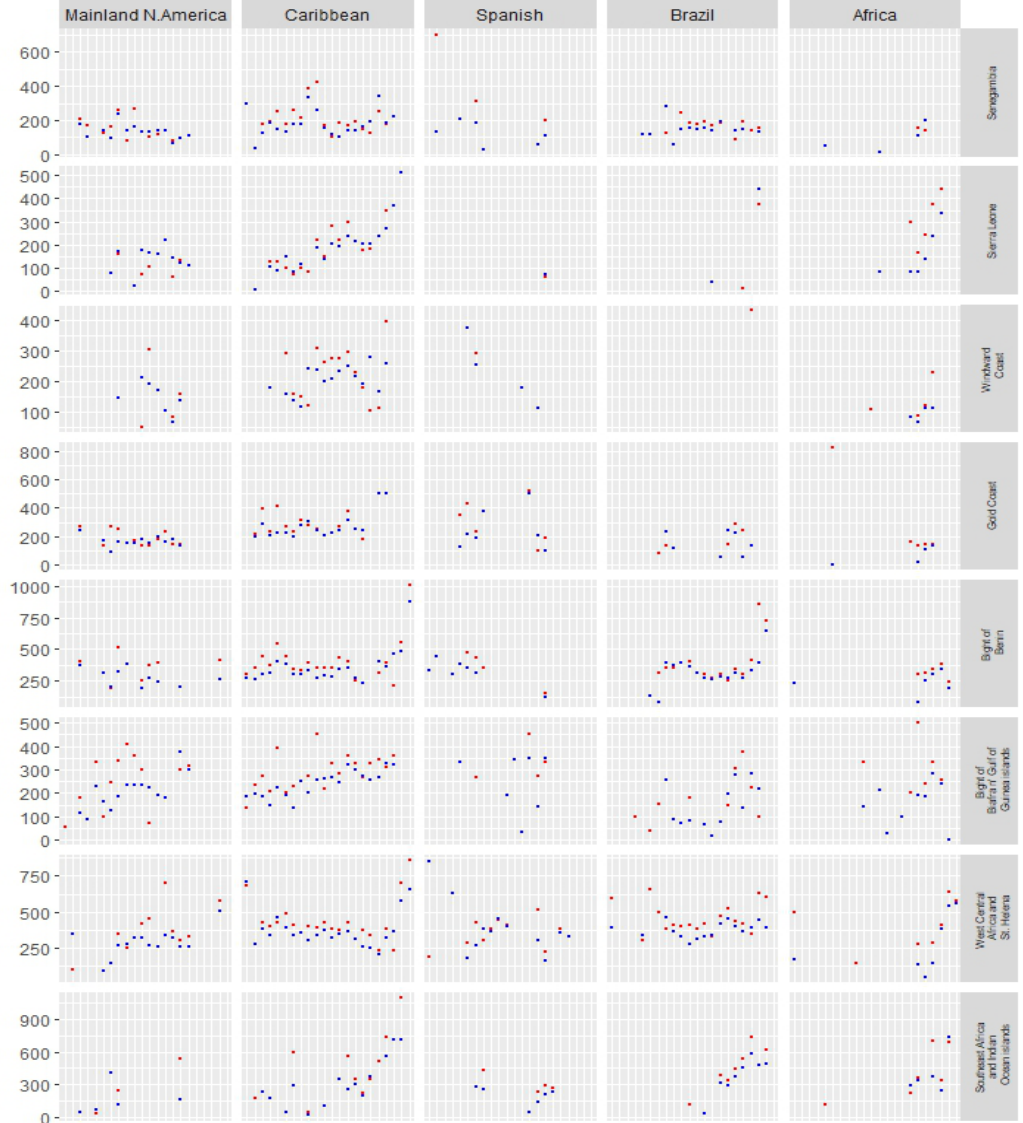
Figure 5. Pattern of documented captive flows within calculated regions. Average embarkation (red) and arrival (blue) populations per voyage, by route by decade. ( Data2a “Documented embarkations,” 7,229 voyages; Data2b “Documented arrivals, 14,008